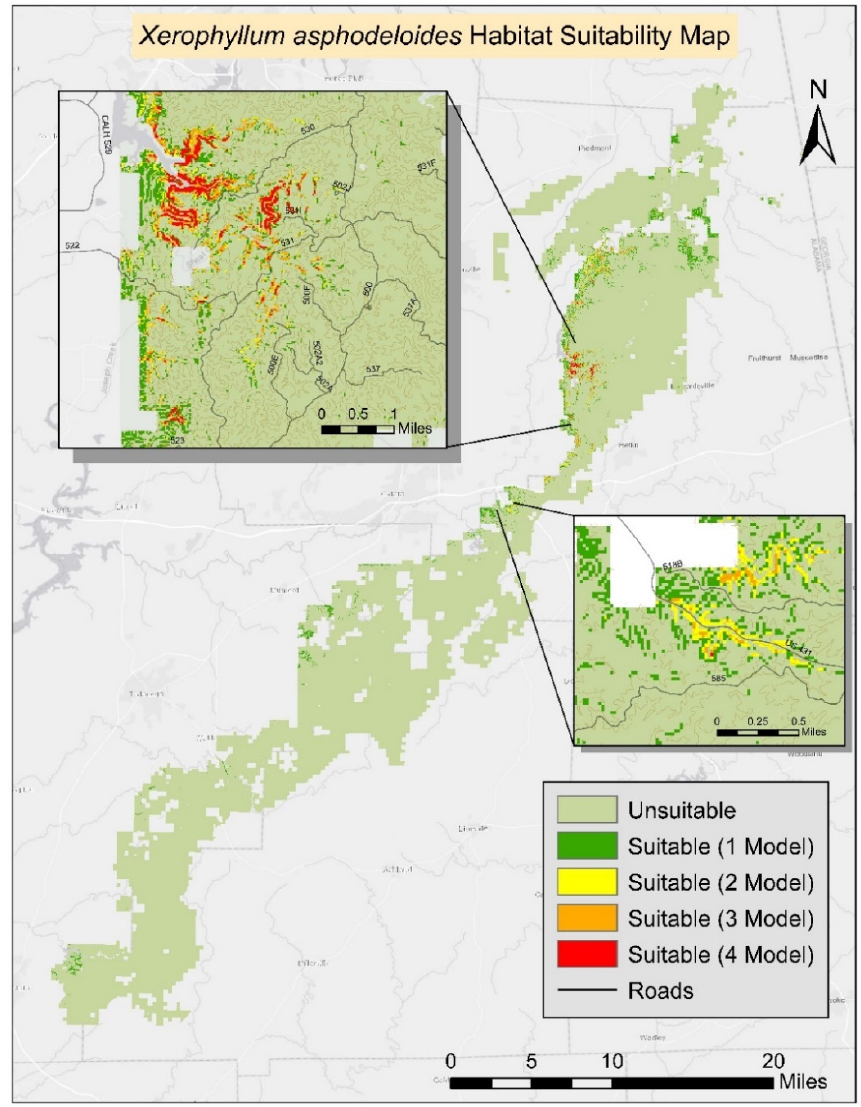
Figure 3. Xerophyllum asphodeloides (turkeybeard) habitat suitability map (Basemaps sources: ESRI). Across all four methods, the most highly contributing (MaxEnt, RF) and significant (GLM, GAM) variable was ground slope. Furthermore, the Bio4 (temperature seasonality) variable was found to be highly contributive for the GLM and MaxEnt models and the elevation variable was found to be highly contributive for the GAM and RF